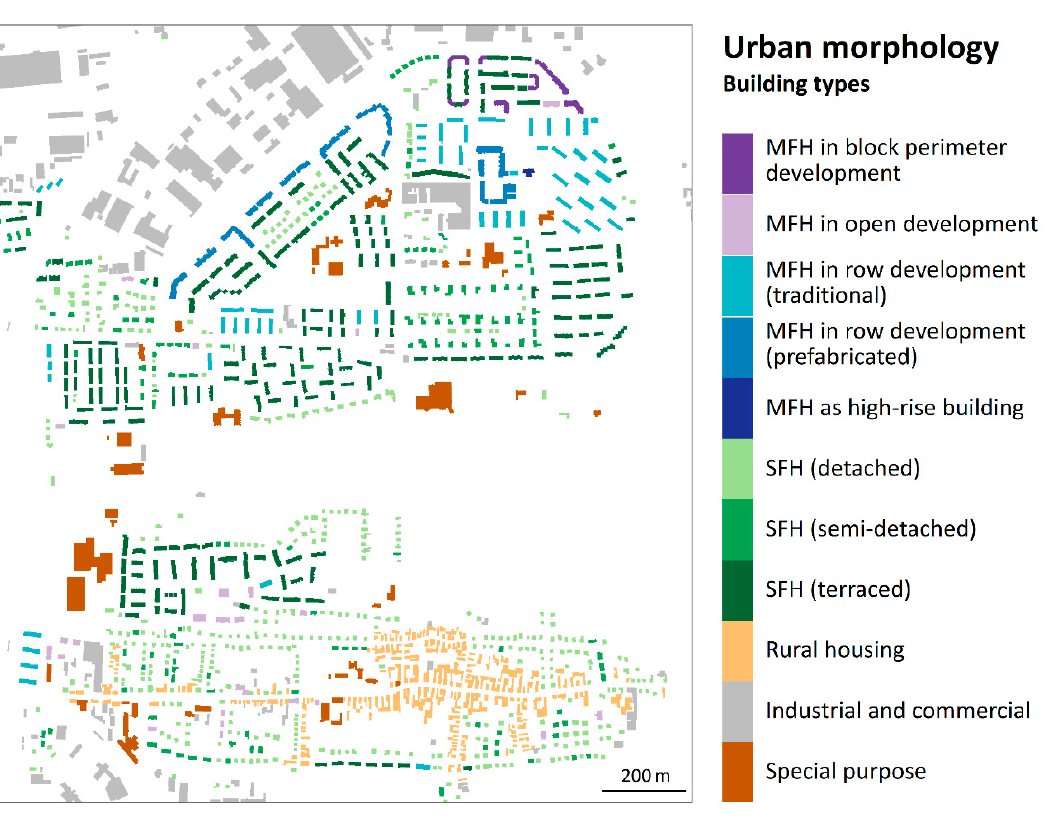
Figure 3. Period of construction derived by intersecting the historical settlement layer at the block level and the building footprints representing historical urban morphologies.